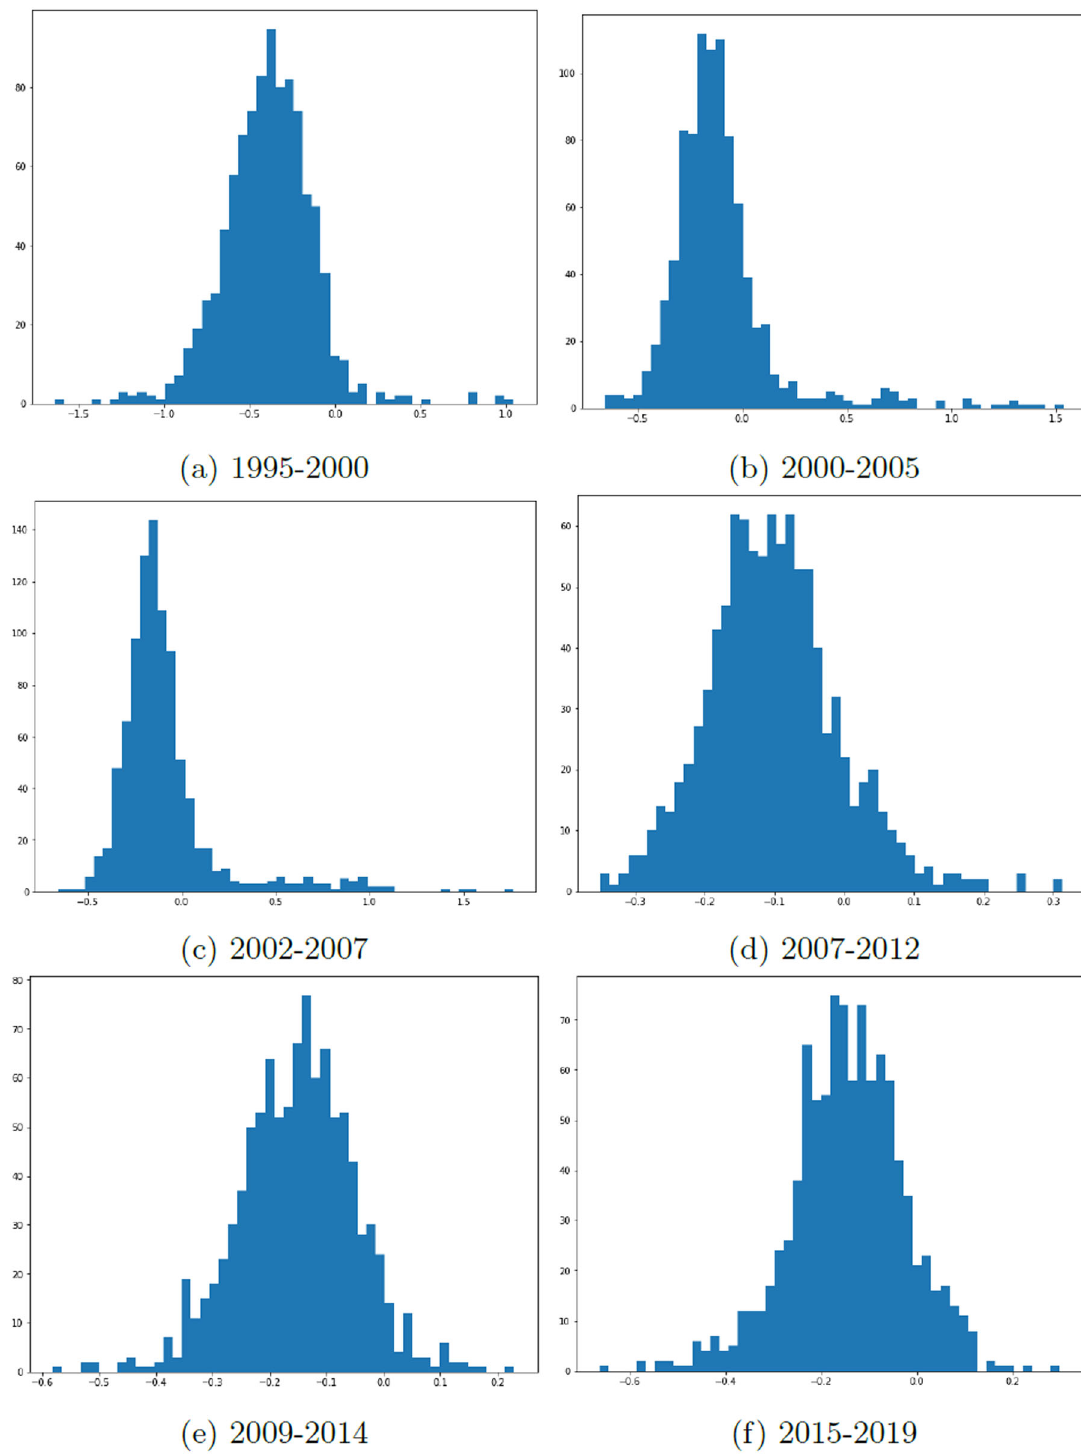
Fig. 3 Histogram of the Sharpe ratio difference between unconstrained and constrained portfolios for 5-year samples. Values less than zero mean that constrained portfolios perform better than unconstrained